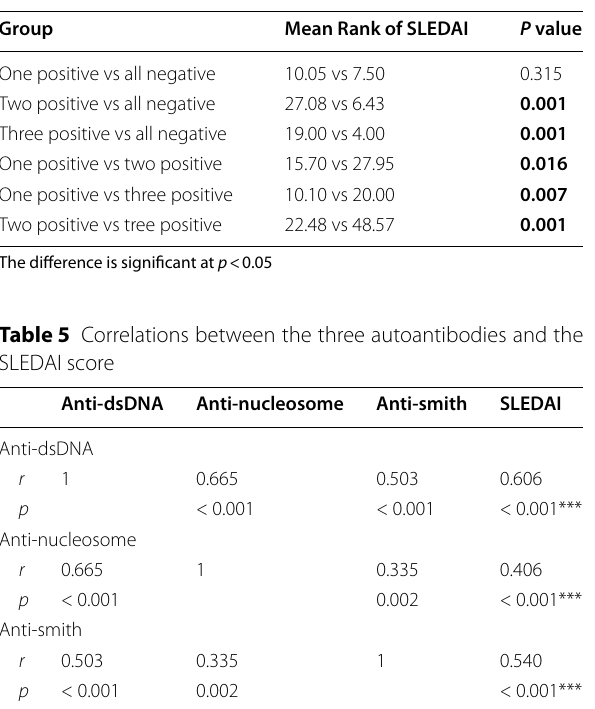
r correlation coefficient ***Correlation is very highly significant at p <